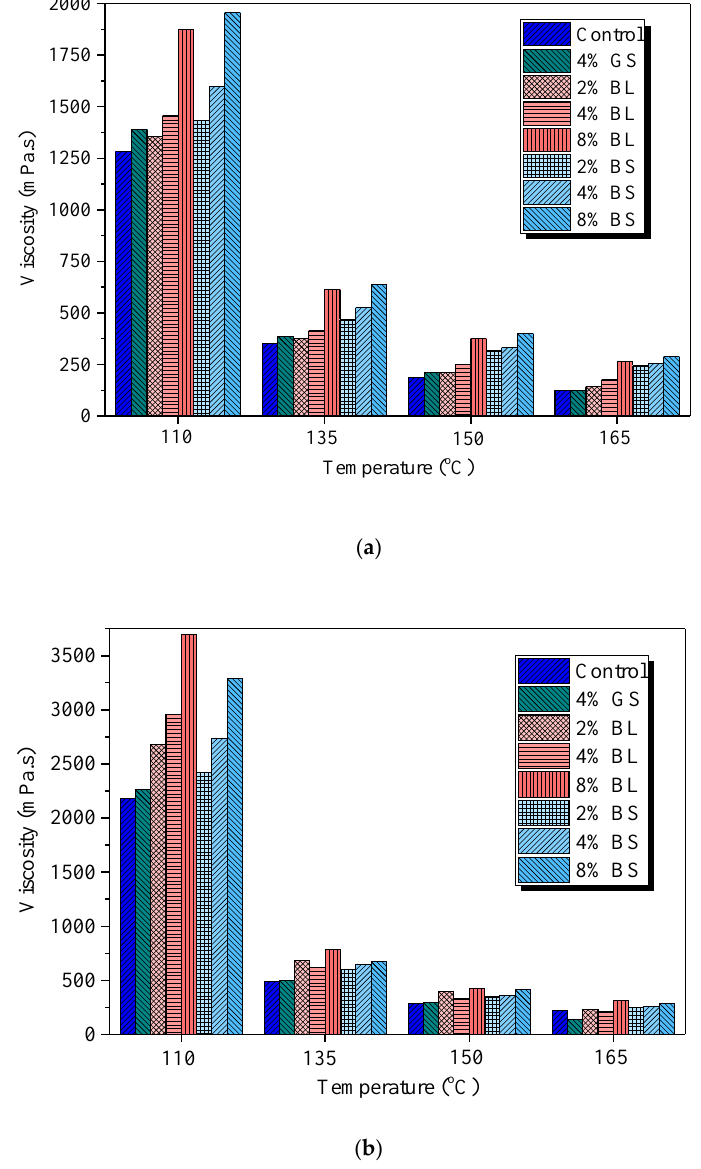
Figure 2. ( a ) Rotational viscosities of original control, graphite modified and bio-char modified asphalts; ( b ) rotational viscosities of control, graphite modified and bio-char modified asphalts after RTFO aging.